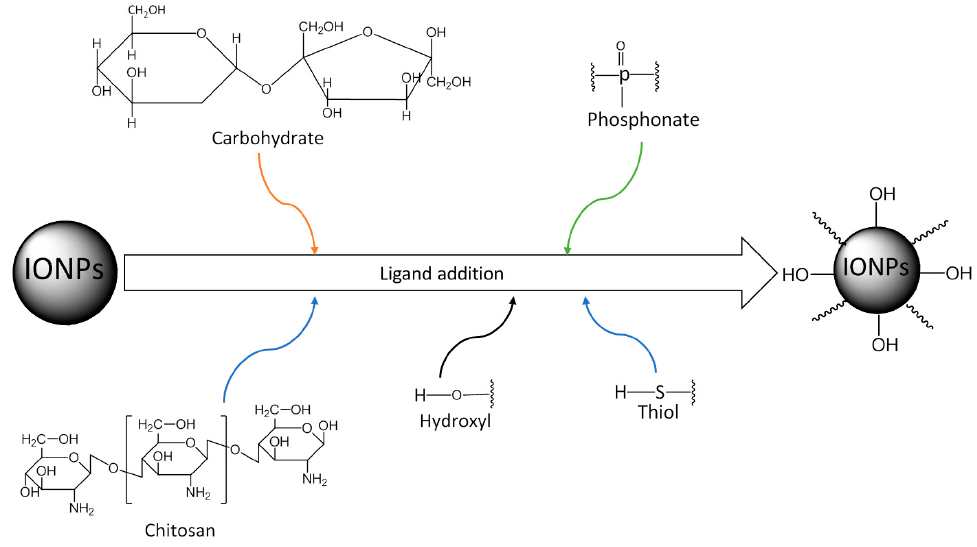
Figure 9. Surface modification of IONPs by ligand addition.